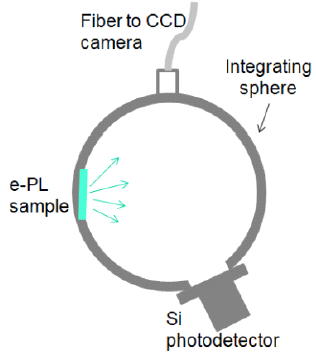
Figure 6. Measurement set-up for assessing the PL signal quantitatively.